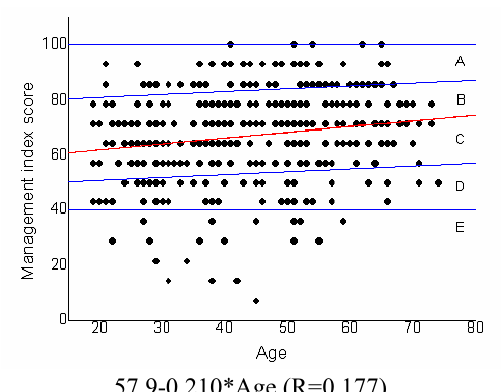
Fig. 6 Regression equation and classification of five regions for management index